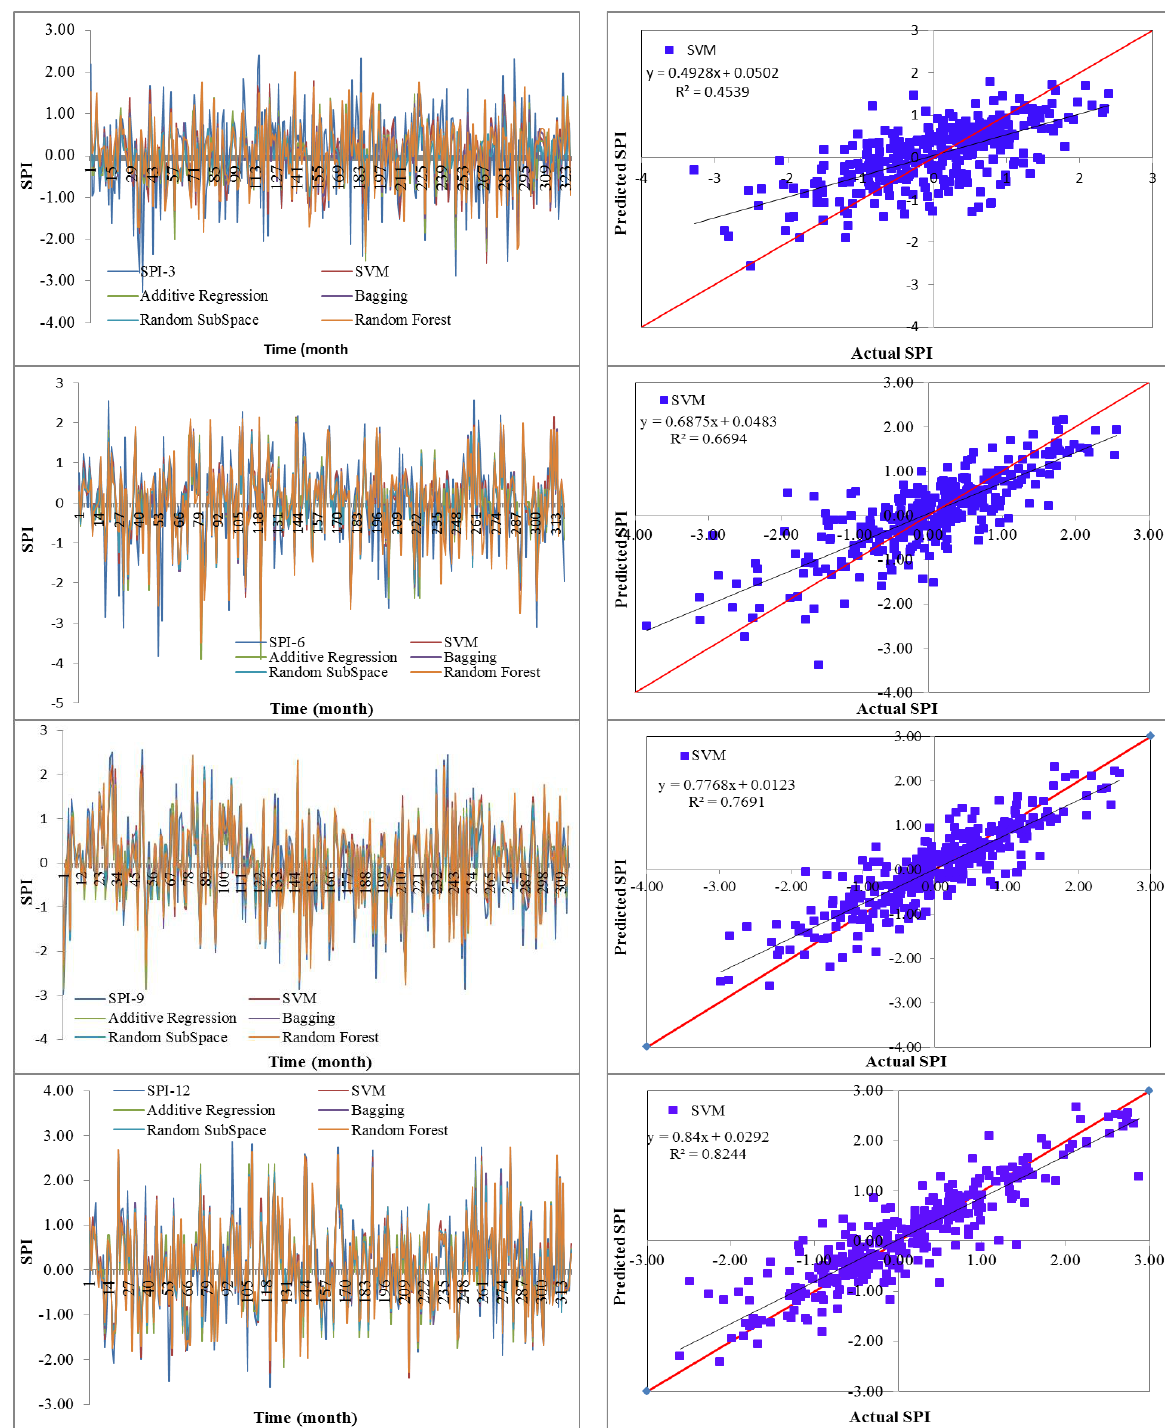
Figure 9. Plots showing the predicted and observed SPI values for 3-, 6-, 9-, and 12-month timeframes during the cross-validation periods at sub-basin